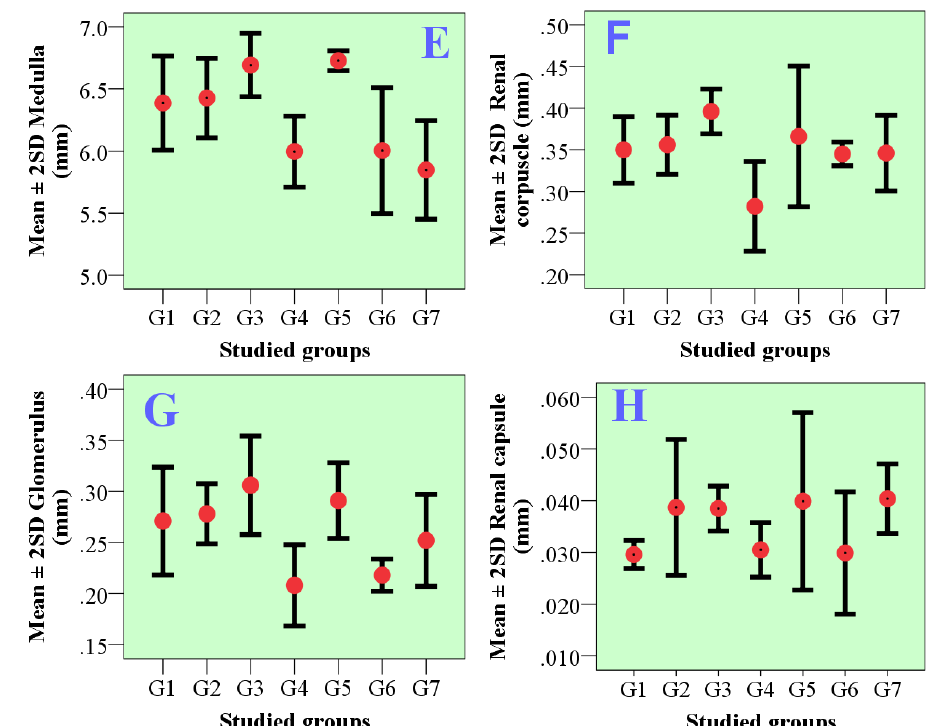
Fig. 4. The comparison of Medulla (E), Renal corpuscle (F), Glomerulus (G), and Renal capsule (H) of different studied groups